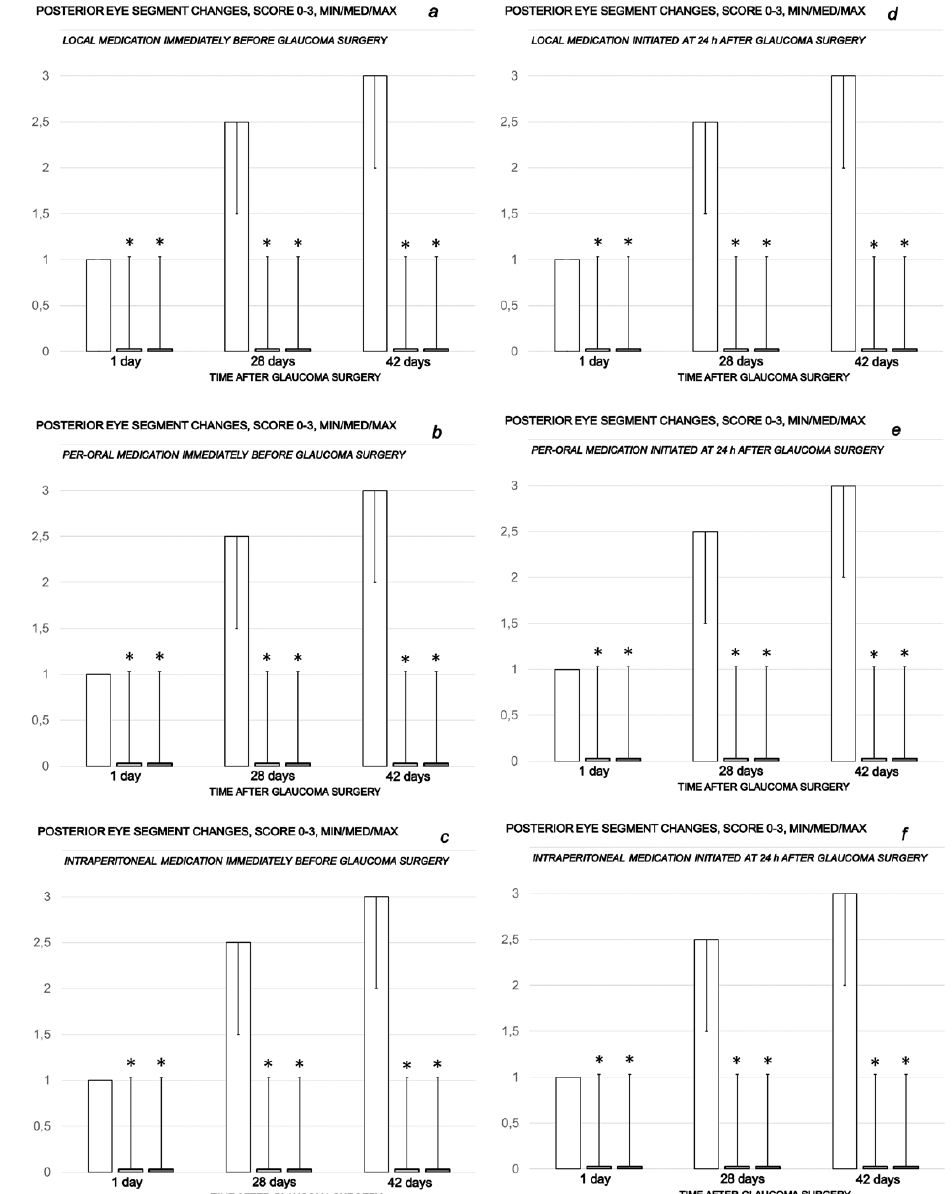
Figure 4. Cauterization of the three episcleral veins induced posterior eye segment changes assessed by fundoscopy, scored 0–3, min/med/max. Counteracting effect of BPC 157 medication daily regimen, prophylactic ( a – c ) or curative ( d – f ) (gray bars, light gray bars µg-regimen, dark gray bars